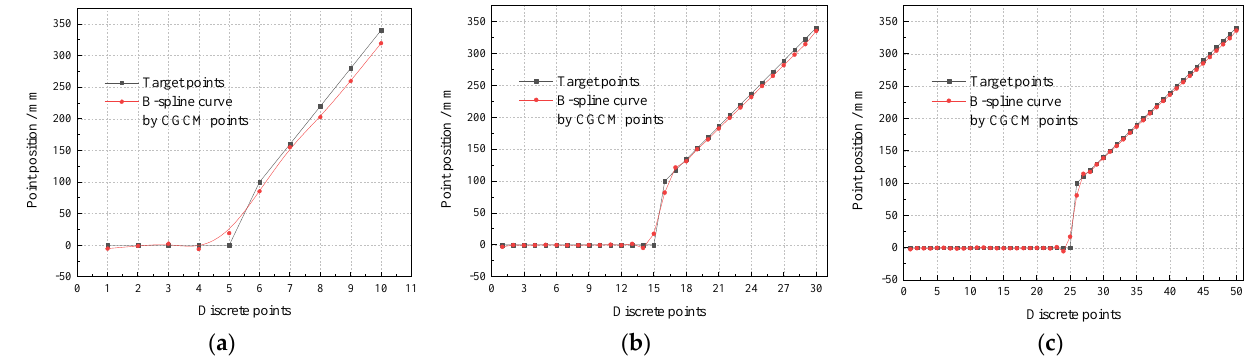
Figure 5. Accuracy verification of generated curve by CGCM. ( a ) 10 discrete points; ( b ) 30 discrete points; ( c ) 50 discrete points.